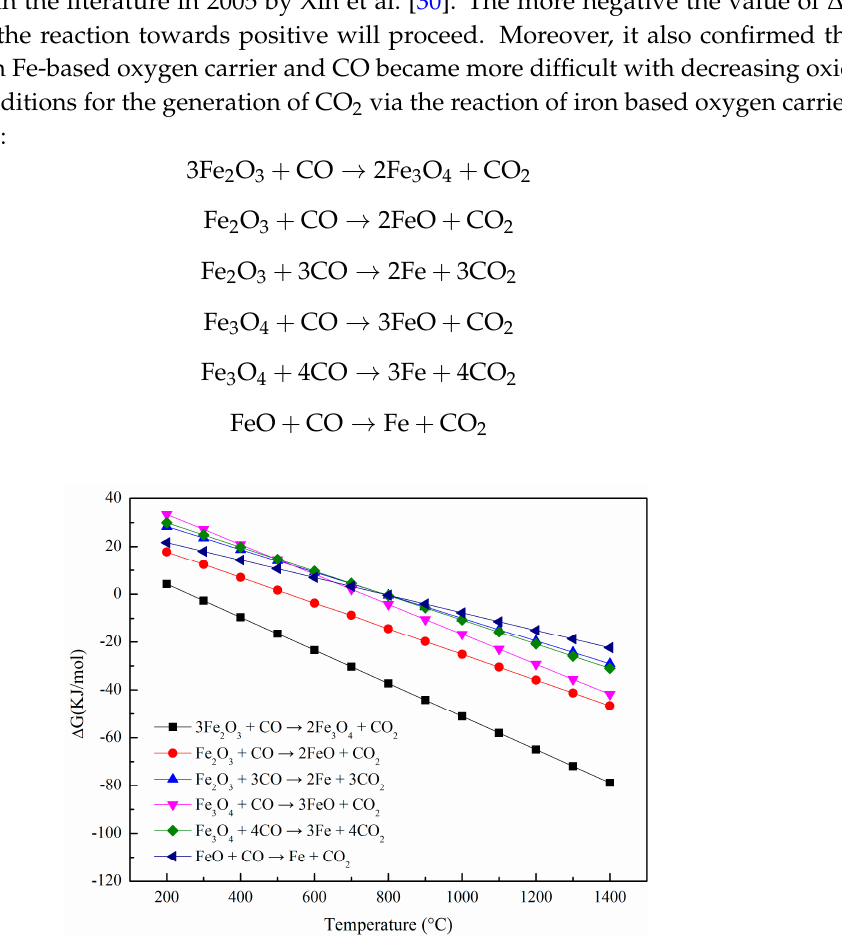
Figure 3. The variations of Δ G with the temperature for Reactions (4)–(9).